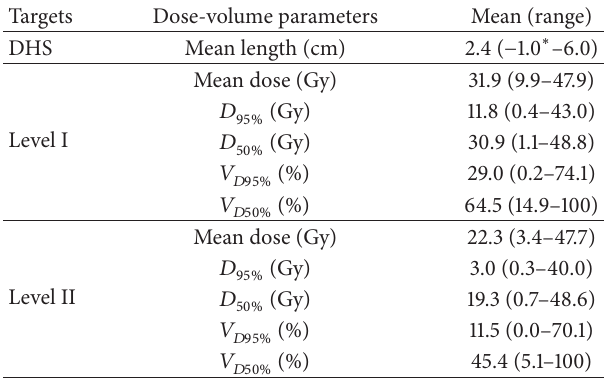
Table 1: Coverage of axillary levels I and II for a total of 27 plans.